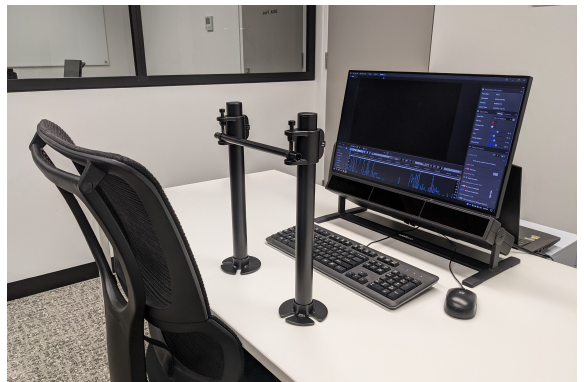
Figure 1. Hardware setup of the Eye-tracking